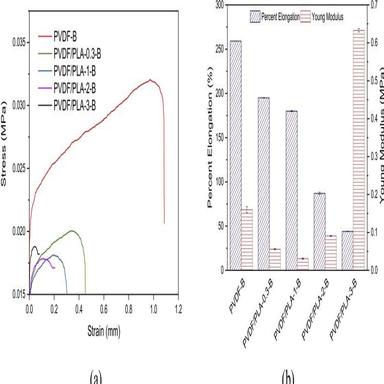
Performance of PVDF membranes with and without PLA modification at different air gap, (a) pure water flux and (b) HA rejection.